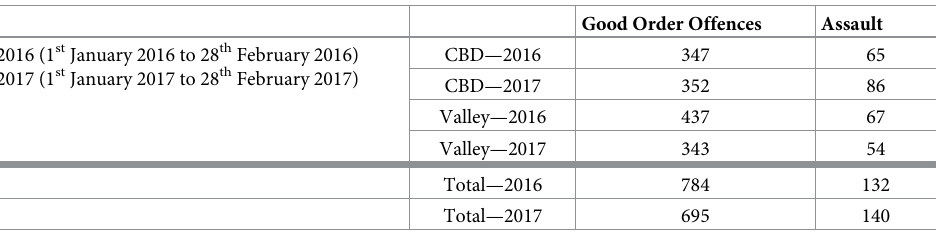
Table 8. Jan—Feb crimes against the person and good order